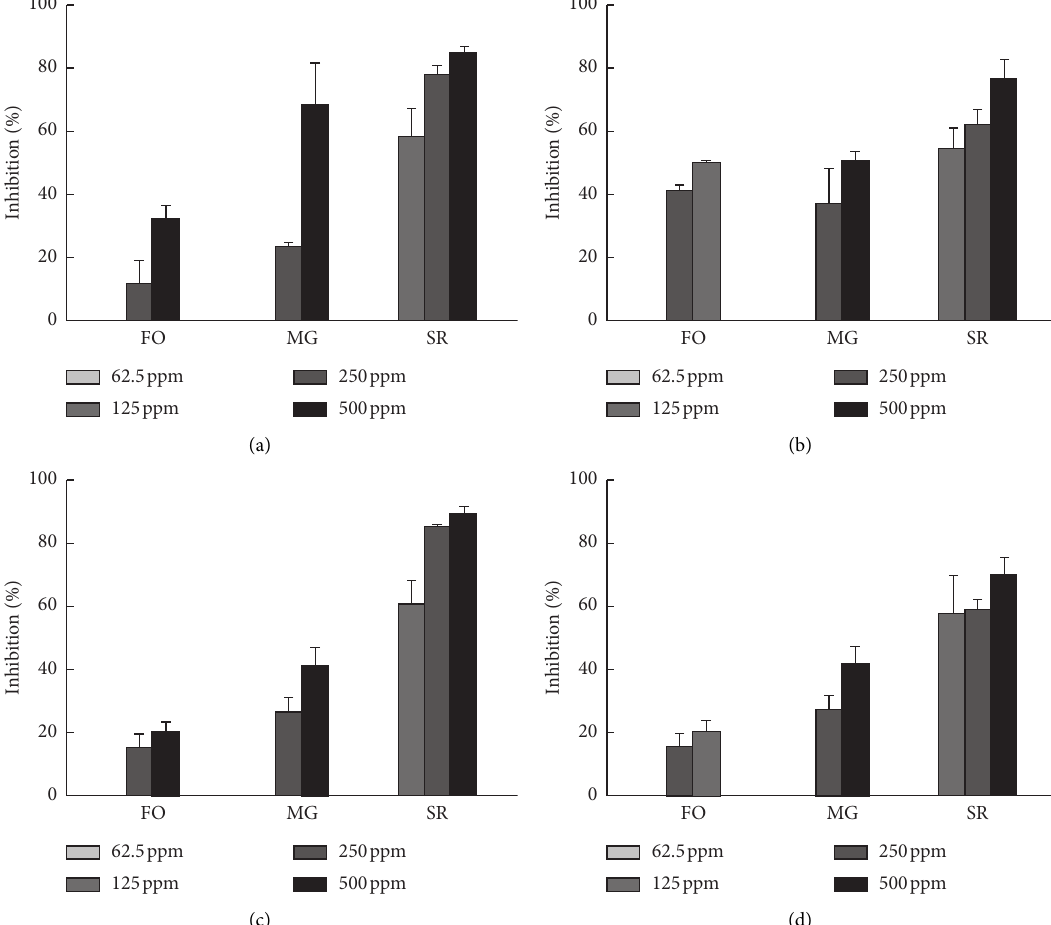
Figure 2: In vitro antifungal activity of the isolated limonoids 2 , 3 , 6 , and 8 against three phytopathogenic fungi. FO: Fusarium oxysporum ; MG: Magnaporthe oryzae ; SR: Sclerotium rolfsii . (a) Compound 2 . (b) Compound 3 . (c) Compound 6 . (d) Compound 8